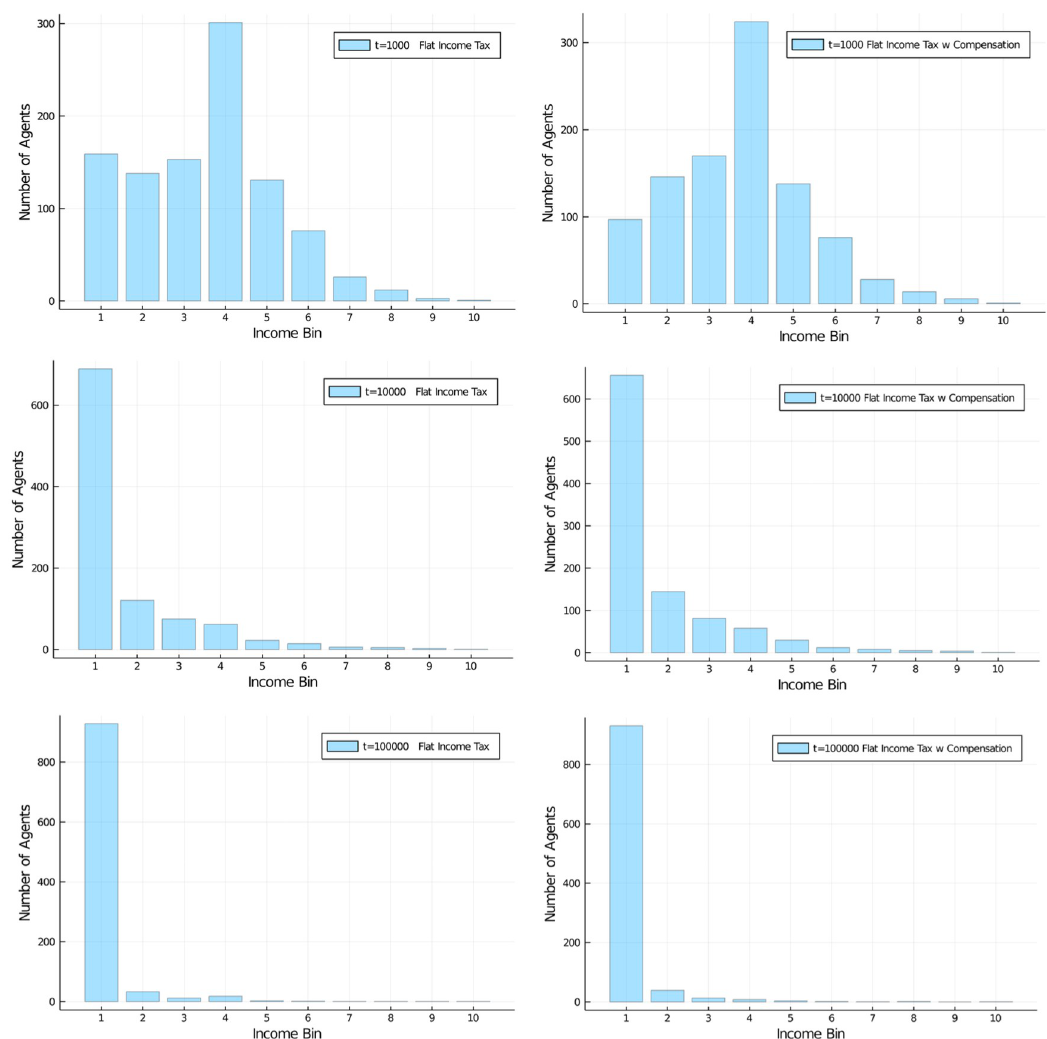
Fig 5. Flat income tax. Wealth distribution in population of 1,000 agents (10 bins, a.u.). Flat income tax regime, with regular flat tax of 30%. Comparison of case l (left) and case II (right) for redistribution policy at t = 1, 000;10, 000; and 100, 000. Initial distribution was equal among all 1,000 agents. Difference is virtually not